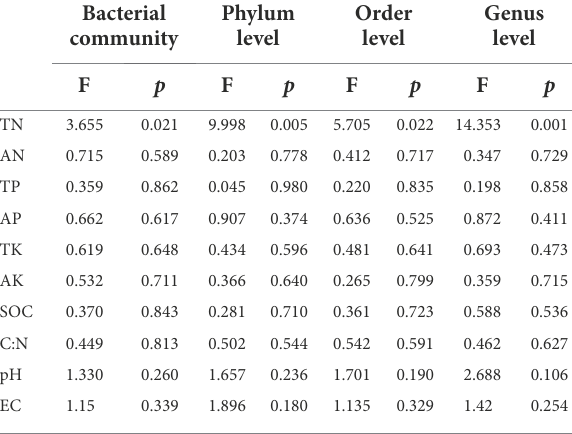
TABLE 4 Redundancy analysis (RDA) of the influence of soil properties on bacterial community and bacterial dominant phylum, order and genus levels in different land use types and